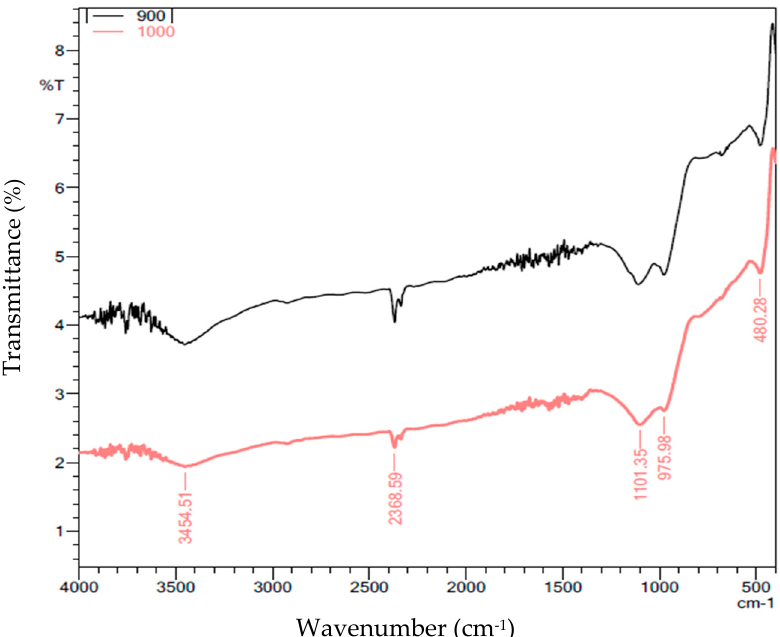
Figure 7. FTIR spectra for 900 °C and 1000 °C MBC.